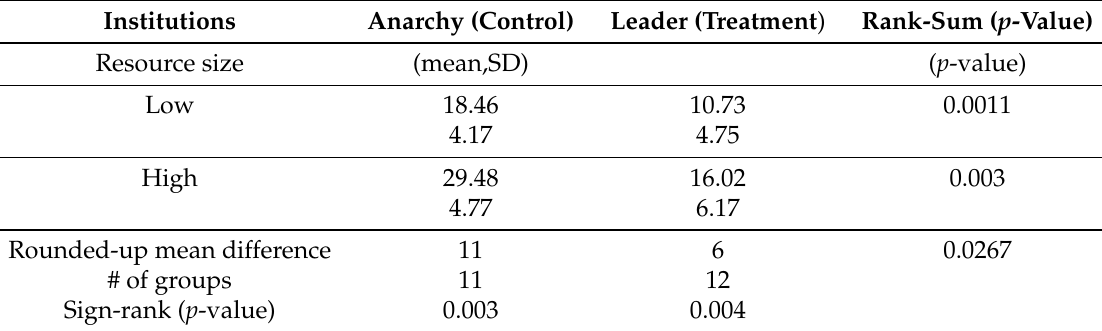
Table 3. Mean impact of resource size and institutions on group conflict.